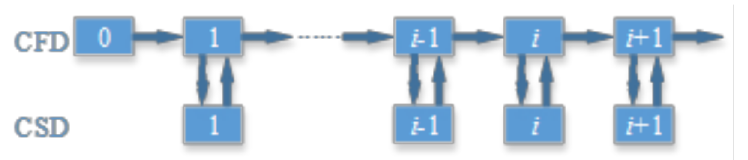
Figure 5. Coupling method 2 between aerodynamics and structural dynamics.